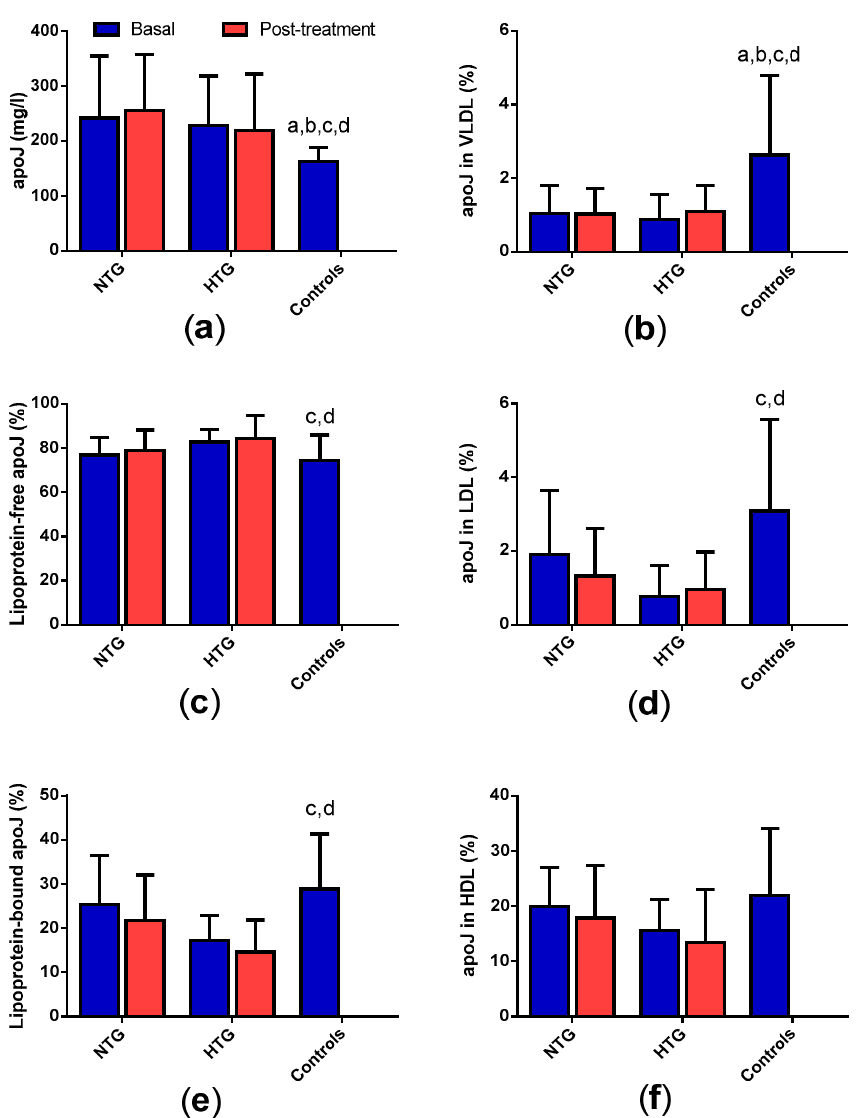
Figure 2. Concentration and distribution of apolipoprotein J (apoJ) in plasma and lipoproteins. ( a ) Total apoJ concentration; ( b , d , f ) proportion of apoJ associated to very low-density lipoprotein (VLDL), low-density lipoprotein (LDL), and HDL, respectively; ( c ) proportion of apoJ not associated to lipoproteins; ( e ) proportion of apoJ associated to lipoproteins. Data are expressed as mean ± SD. * p < 0.05 vs. basal samples. a p < 0.05 vs. basal NTG. b p < 0.05 vs. NTG post-treatment. c p < 0.05 vs. basal HTG. d p < 0.05 vs. HTG post-treatment.